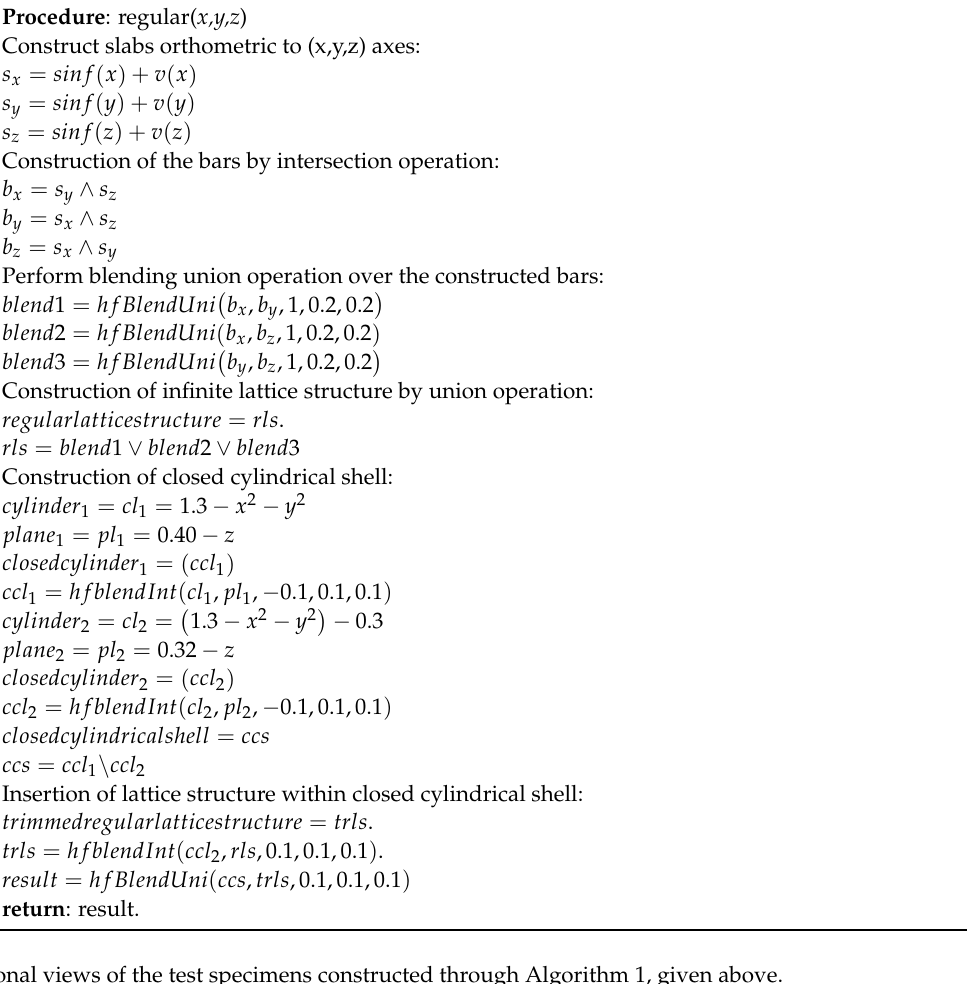
Algorithm 1 Construction of a cellular lattice structure within closed cylindrical object